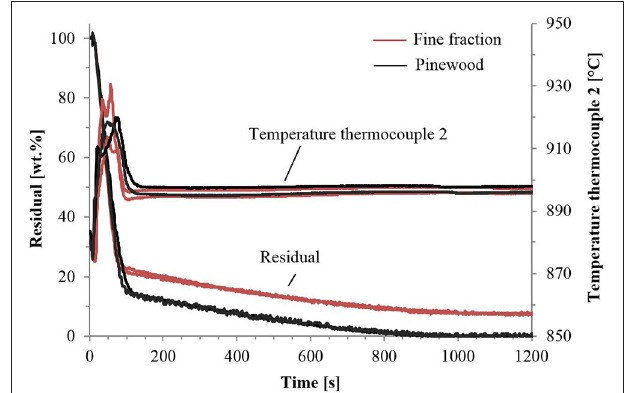
FIGURE 7 | Temperature above the sample and residual of seven pellets during the combustion at 900 ◦ C with ˙V tech.air = 10